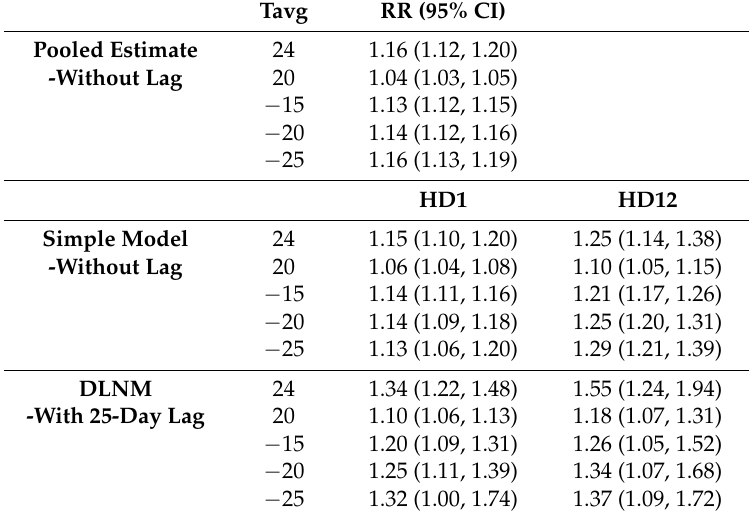
Table 2. Comparison of the relative mortality risk, RR (95% CI), in HD1 and HD12 at selected temperatures in three model versions: pooled model without lag and seasonal variation, a simple model without lag and seasonal variation, a DLNM with 25 ‐ day lag and seasonal variation.